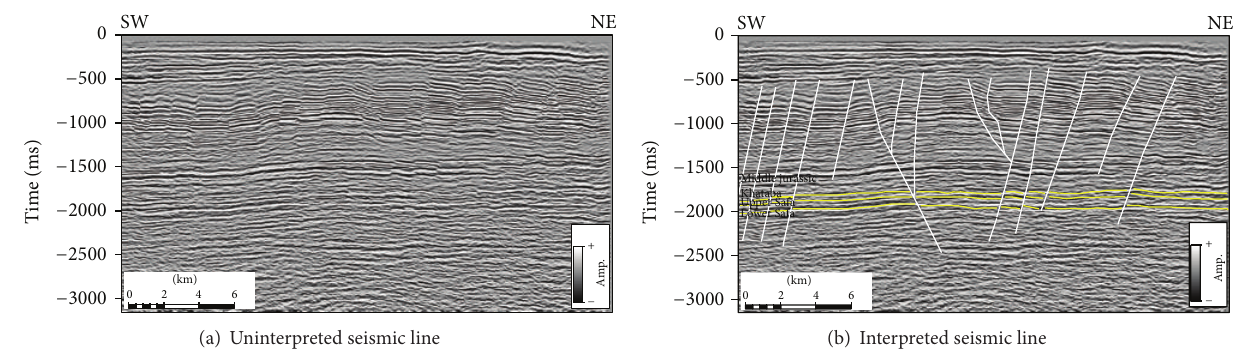
Figure 6: (a) Uninterpreted seismic line and (b) interpreted seismic line in SW-SE direction showing a complex structural pattern in the Shushan Basin (Egypt).